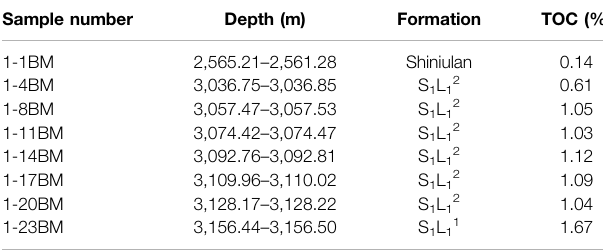
TABLE 1 | The samples of isothermal adsorption in well